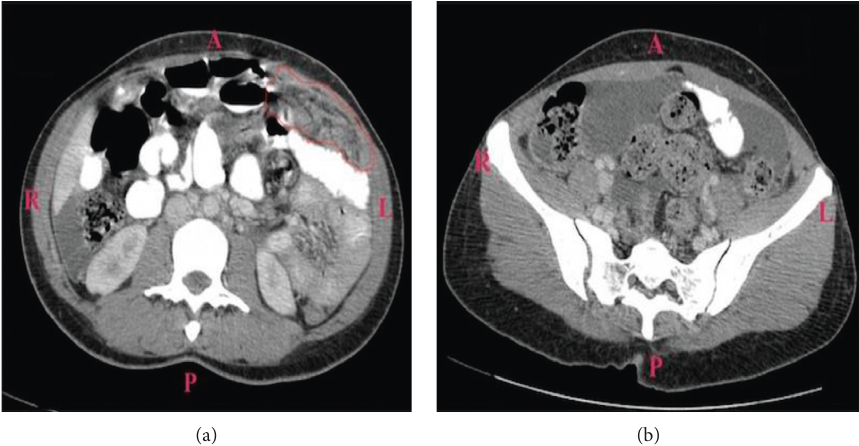
Figure 2: Computed tomography of the abdomen and pelvis with contrast. Diffuse mesenteric enhancement in the left upper quadrant suspicious for carcinomatosis (a) and multiloculated cystic mass adjacent to the right adnexa suspicious for ovarian neoplasm